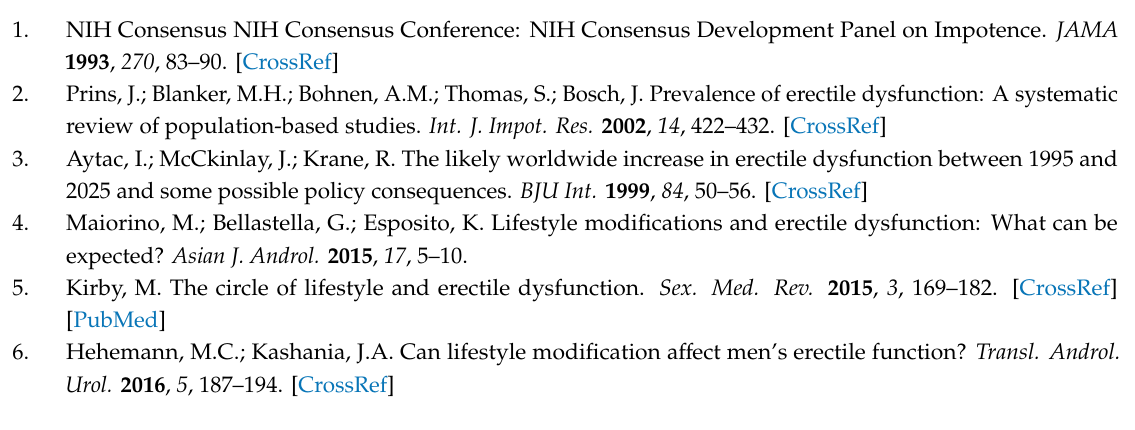
Table S1: Average nutrient composition of studied nuts (per 100